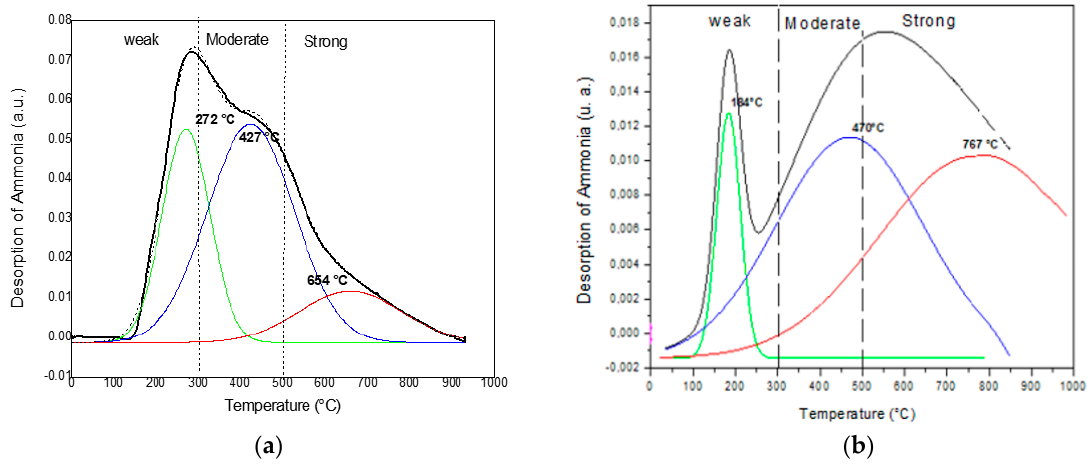
Figure 2. TPD ammonia analysis of SAPO-5 ( a ); TPD ammonia analysis of Al-MCM-41( b ).